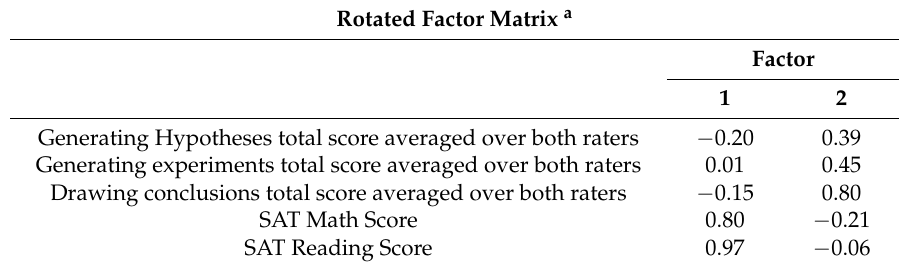
Table 6. Rotated maximum likelihood common factor matrix in the Study 1 factor analysis of the total scores of our subscales and SAT scores.